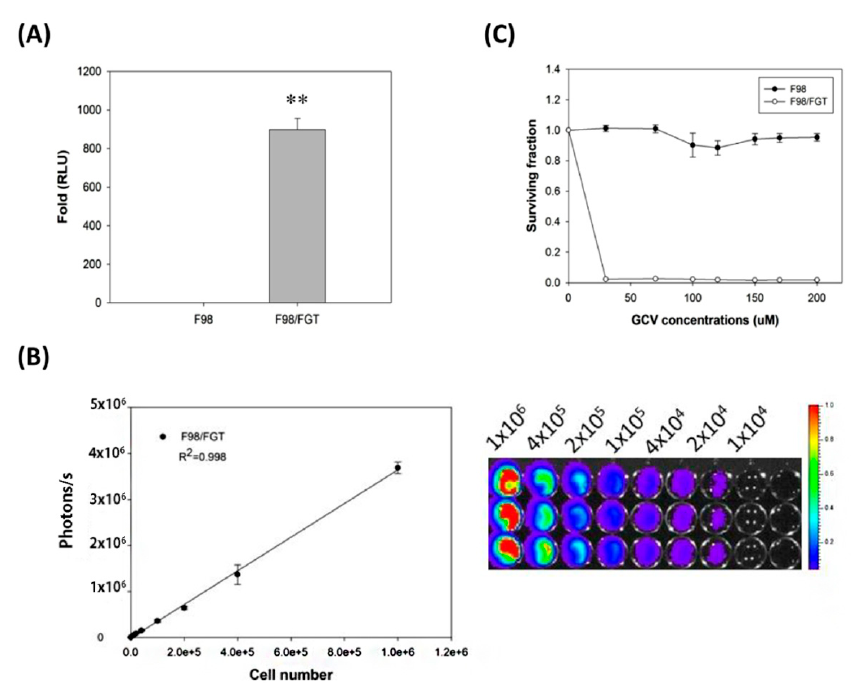
Figure 5. Validation of constructed luciferase and thymidine kinase ( tk ) genes and their expressions. ( A ) The expressions of luciferase gene of F98 and F98/ FGT cells were presented as relative luminometer units (RLU). The difference of RLU between two cell lines were about 900 times and was significant (** p < 0.01). ( B ) The luciferase activity (photons/second) of F98/ FGT glioma was proportional to the cell number with R 2 = 0.998. ( C ) Ganciclovir (GCV) and MTT assay were used to validate the tk expression. About 99% of F98/FGT cells were killed when concentration of GCV ≧ 30 μ M, while F98 parental cells were not affected.